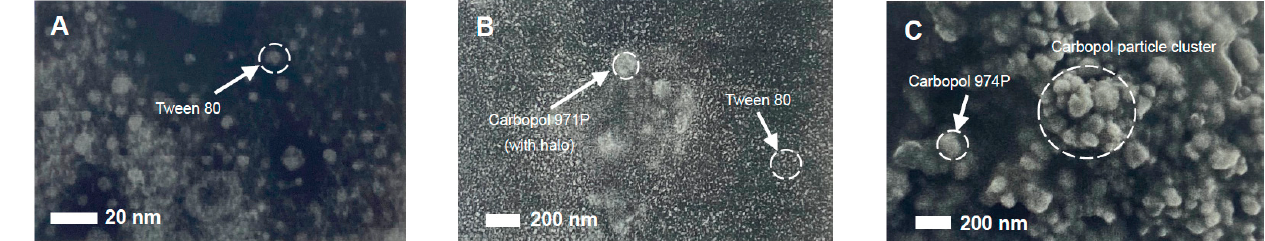
Figure 11. Scanning electron microscopy (SEM) images at an operating acceleration voltage of 2–5 keV. SEM images of pure 1 mM Tween 80 samples ( A ) and also 1 mM Tween 80 in the presence of a low loading of 0.1% w / v dispersions of carbopol 971P ( B ) and a higher loading of 2% w / v dispersions of carbopol 974P ( C ). Samples that included carbopols showed the presence of large 100–200 nm particles (images B and C), which associated into even larger aggregates (>500 nm), as shown in the SEM image at the higher concentration for carbopol 974P. All solutions used for samples were prepared from surface chemically pure 50 mM sodium phosphate buffered water, pH 7.0. Images are not all on the same scale.